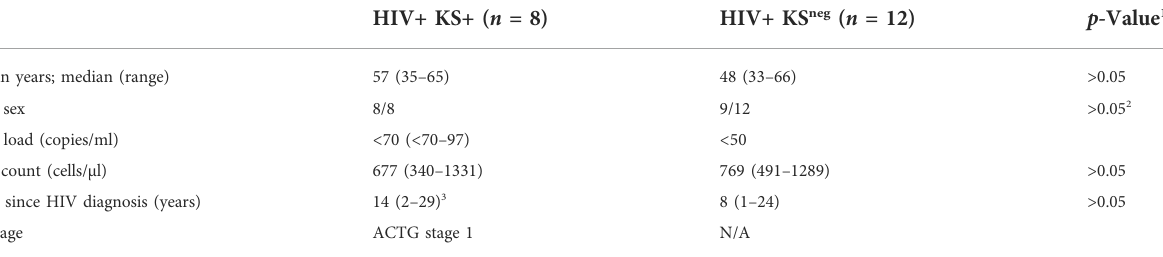
TABLE 1 Participant